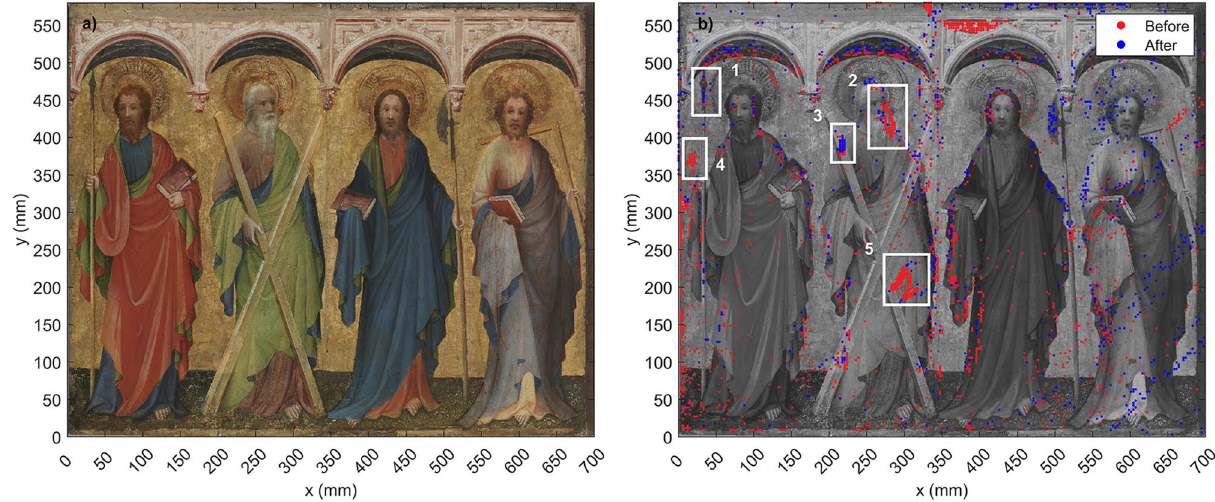
Figure 1. ( a ) Visible color photograph of The Apostles Philip, Andrew, Mattias and Thomas (c.1410-25). ( b ) THz mapping of delamination on the painting before (red) and after (blue) the consolidation effort. Delamination is denoted by dense groups of markers. Enclosed in white boxes are the five regions of interest that were selected for further